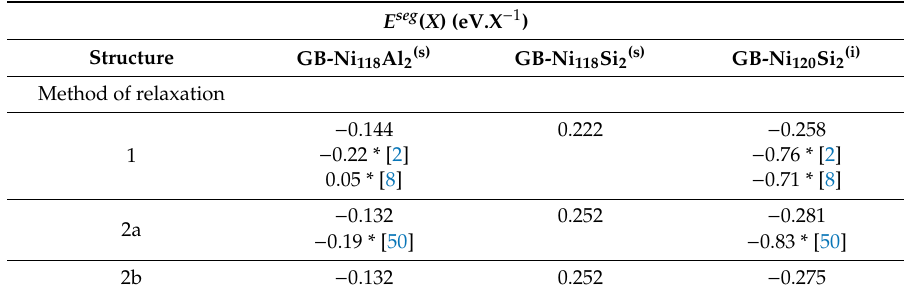
Table 4. Segregation energies obtained by di ff erent methods of relaxation. Here eV.X − 1 stands for eV per atom of